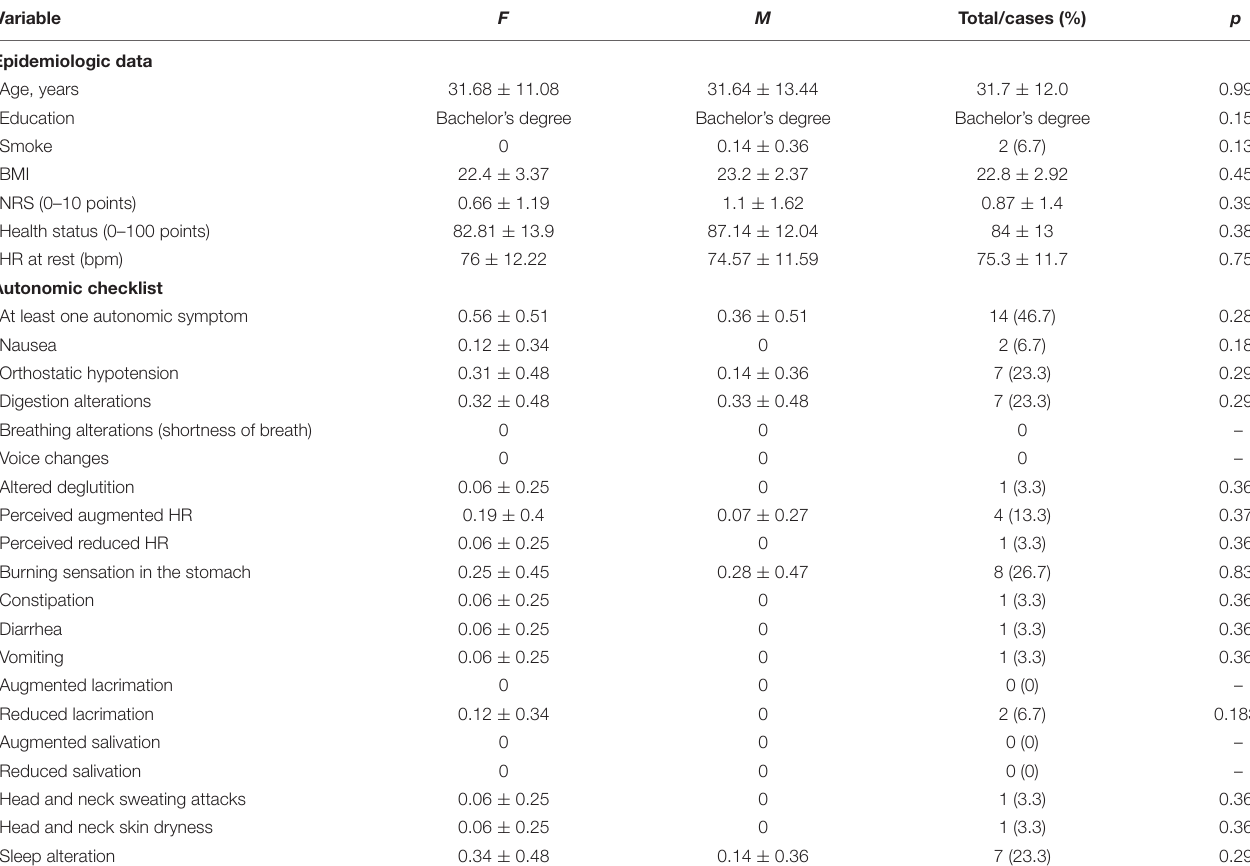
TABLE 1 | Differences between sexes at baseline characteristics and reported autonomic signs and symptoms (experienced during the last 7 days). Variable F